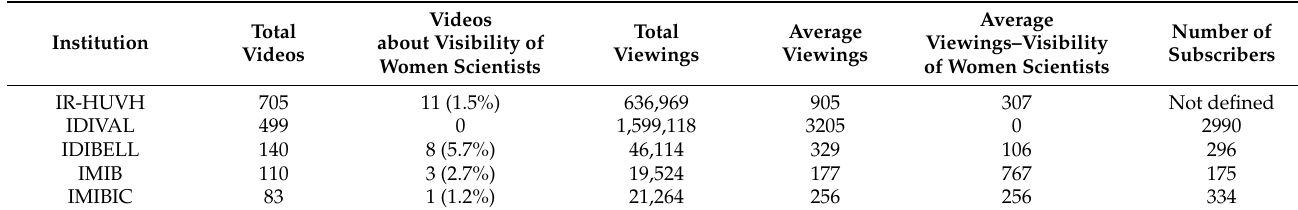
Table 1. Metrics of interaction with the user of the channel in general and with the content about the visibility of women scientists. Institution